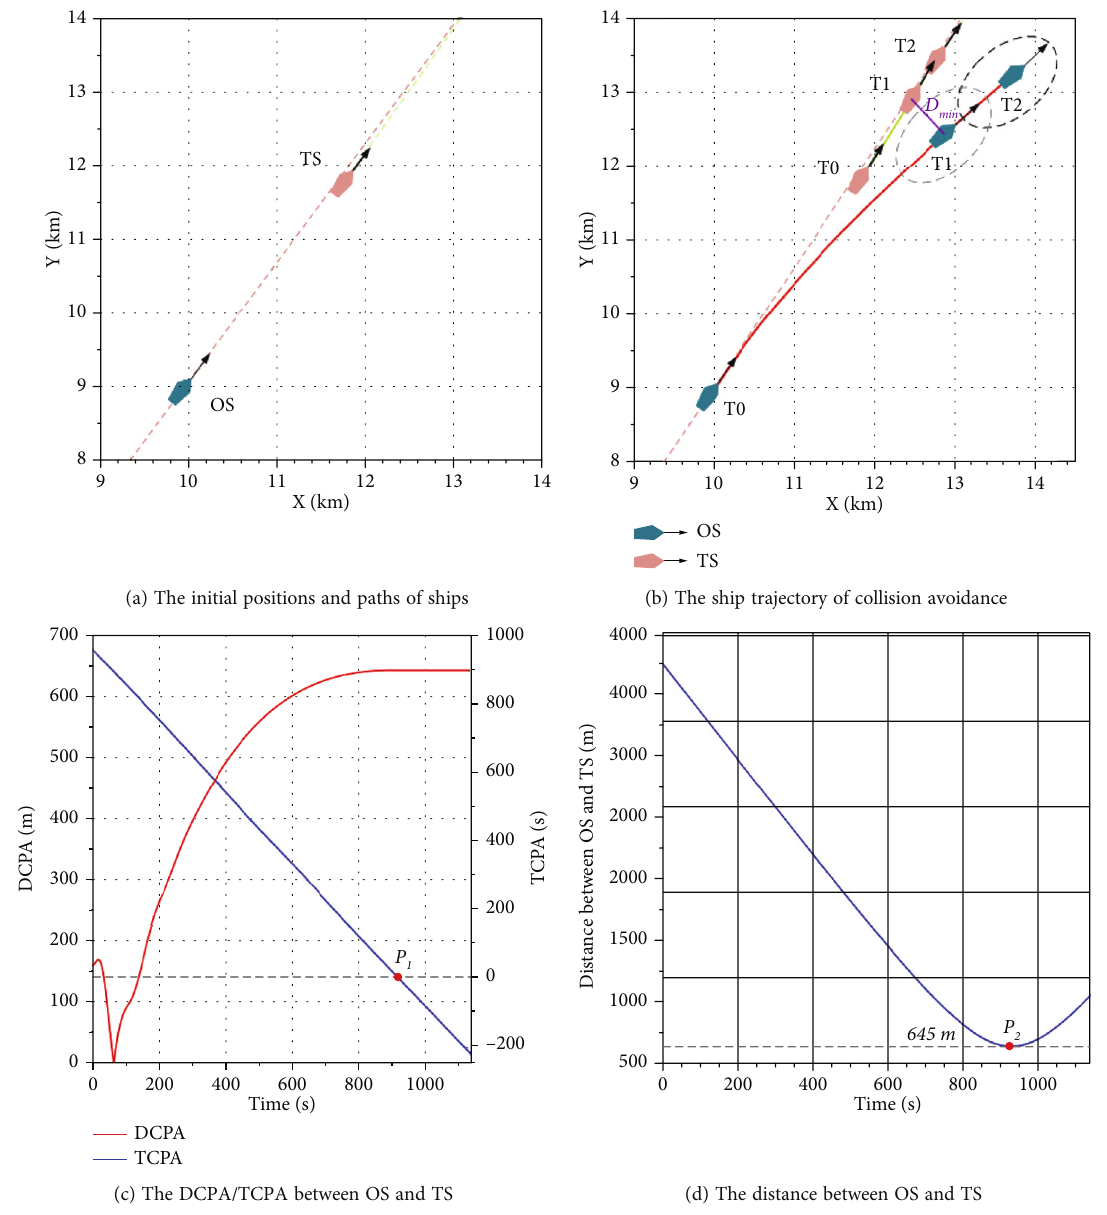
Figure 14: The simulation results under overtaking encounter situation. Table 8: Initial information of the ships for crossing